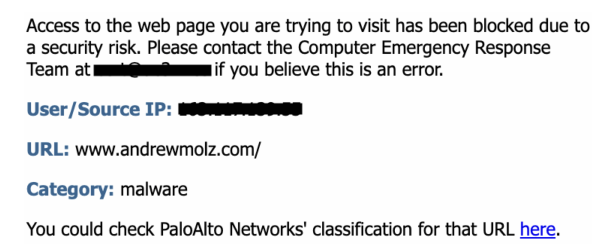
Figure 2. Snapshot of the message shown by our institution when clicking on the ad depicted in Figure 1. The click action redirects the user to a malvertiser landing domain. The connection was blocked by our institution firewall because the landing domain is identified as unsafe. Some text in the figure is hidden for double-blind